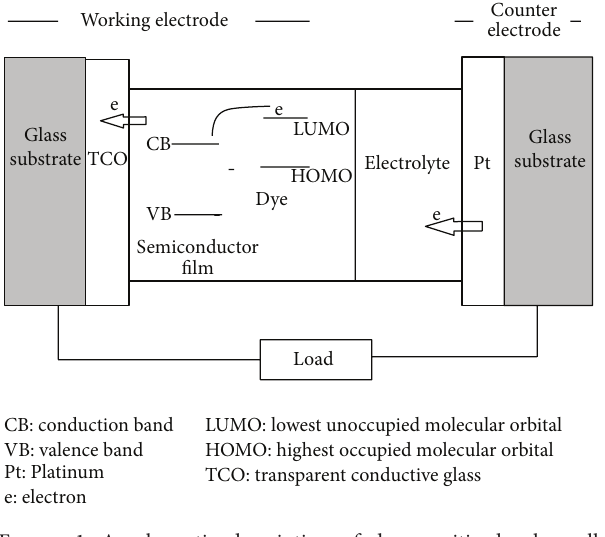
Figure 1: A schematic description of dye sensitized solar cell